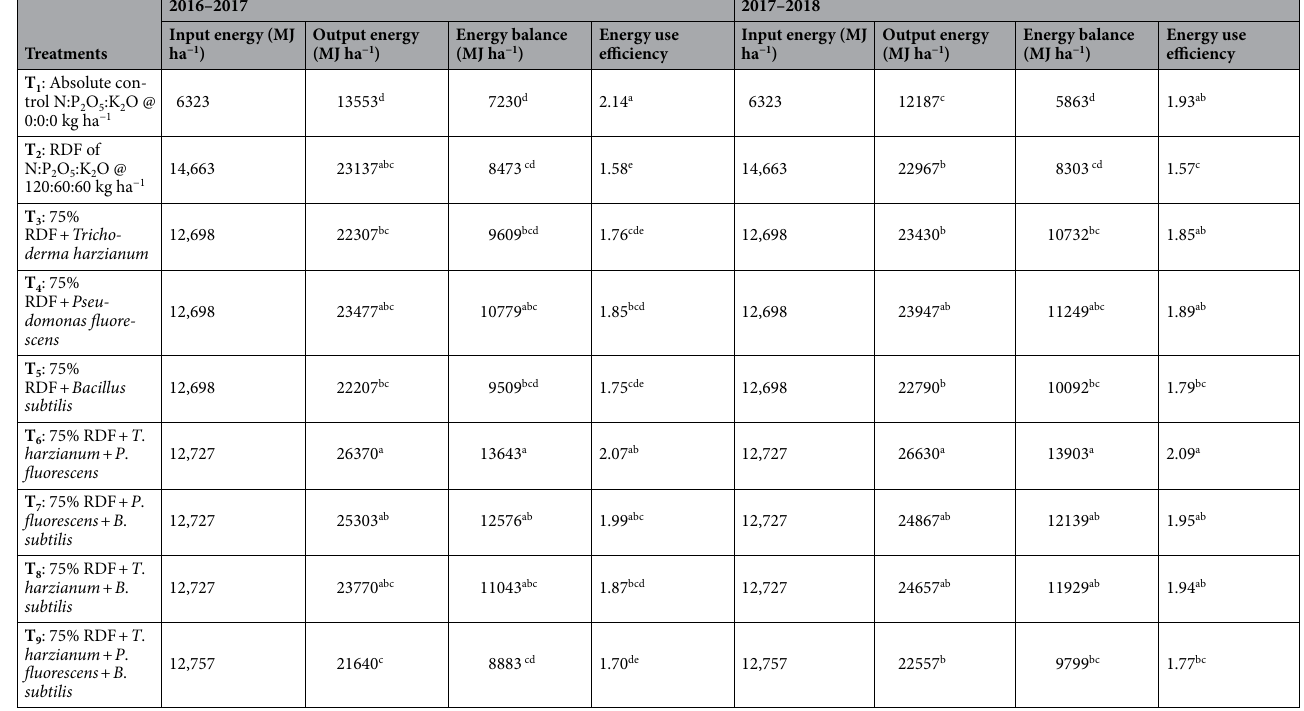
Table 4. Energetics of red cabbage production as influenced by bio-priming and mineral fertilization. Different letters indicate significant differences at P ≤ 0.05 among the treatments as per DMRT.